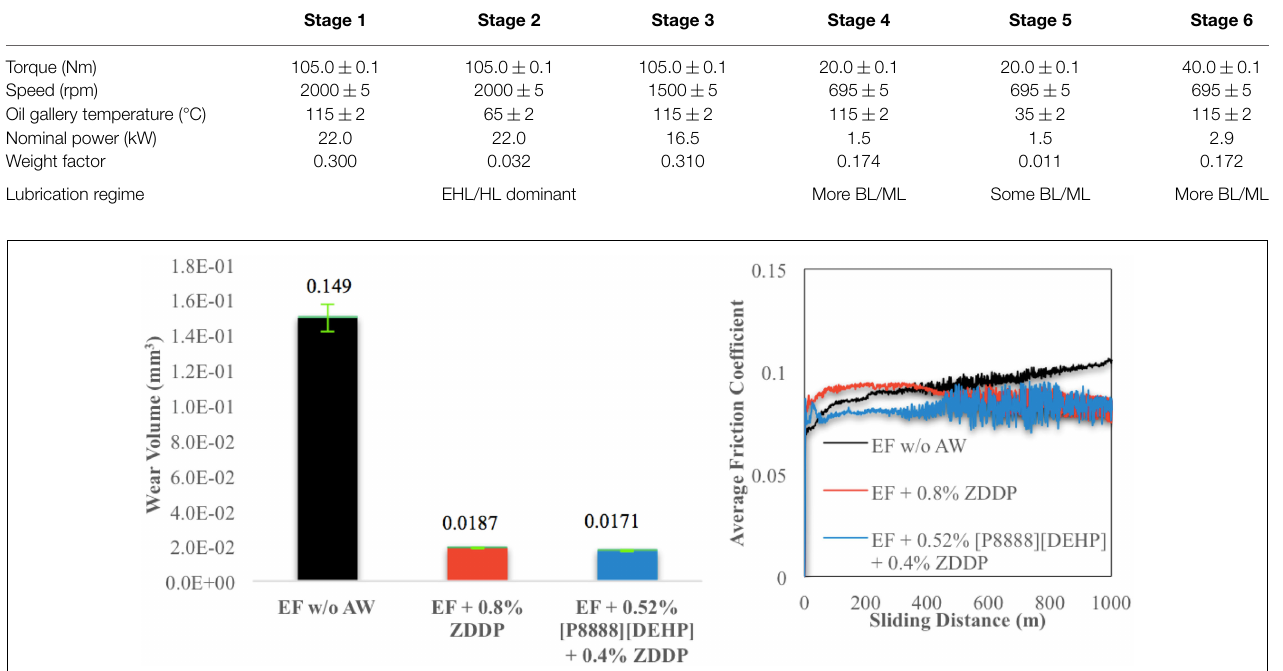
TABLE 5 | Sequence VIE fuel economy engine test conditions .